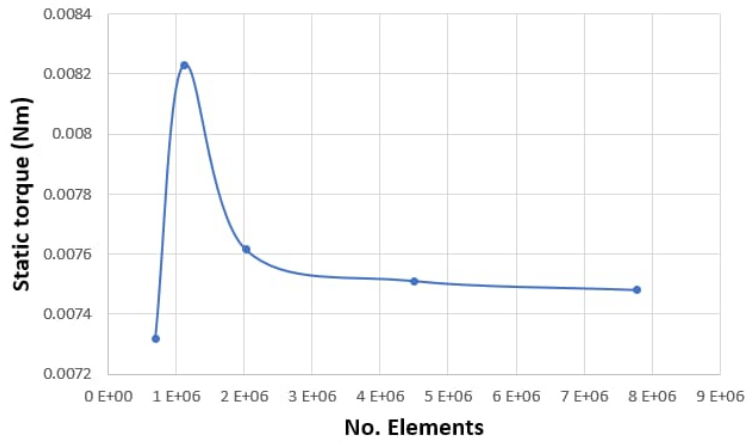
Figure 11. Relation between static torque and the number of elements at an air velocity of 15.8 m/s for the IceWind turbine at θ = 90°.